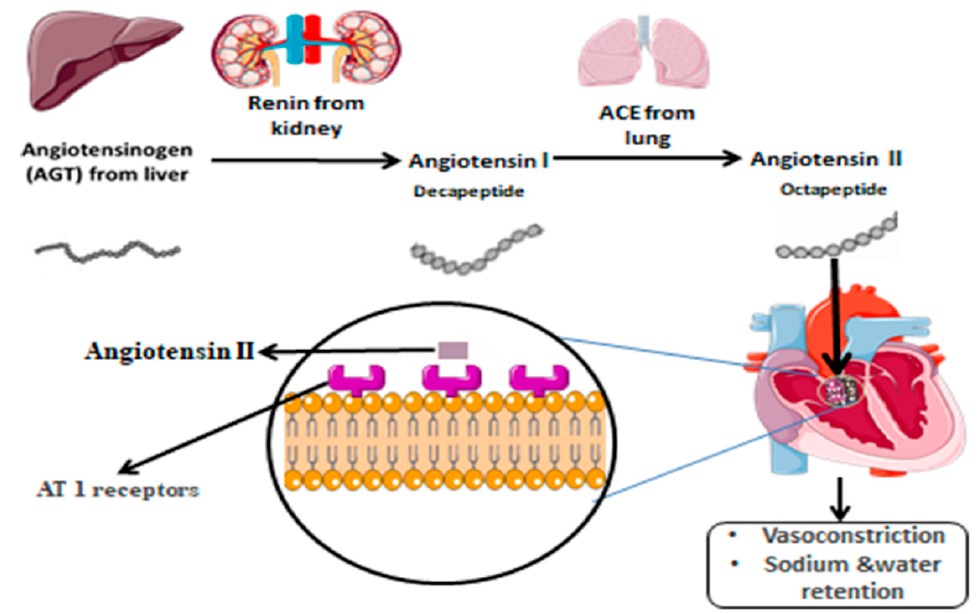
Figure 1. Graphical representation of the mechanism of action of AGT that is involved in the renin-angiotensin system.